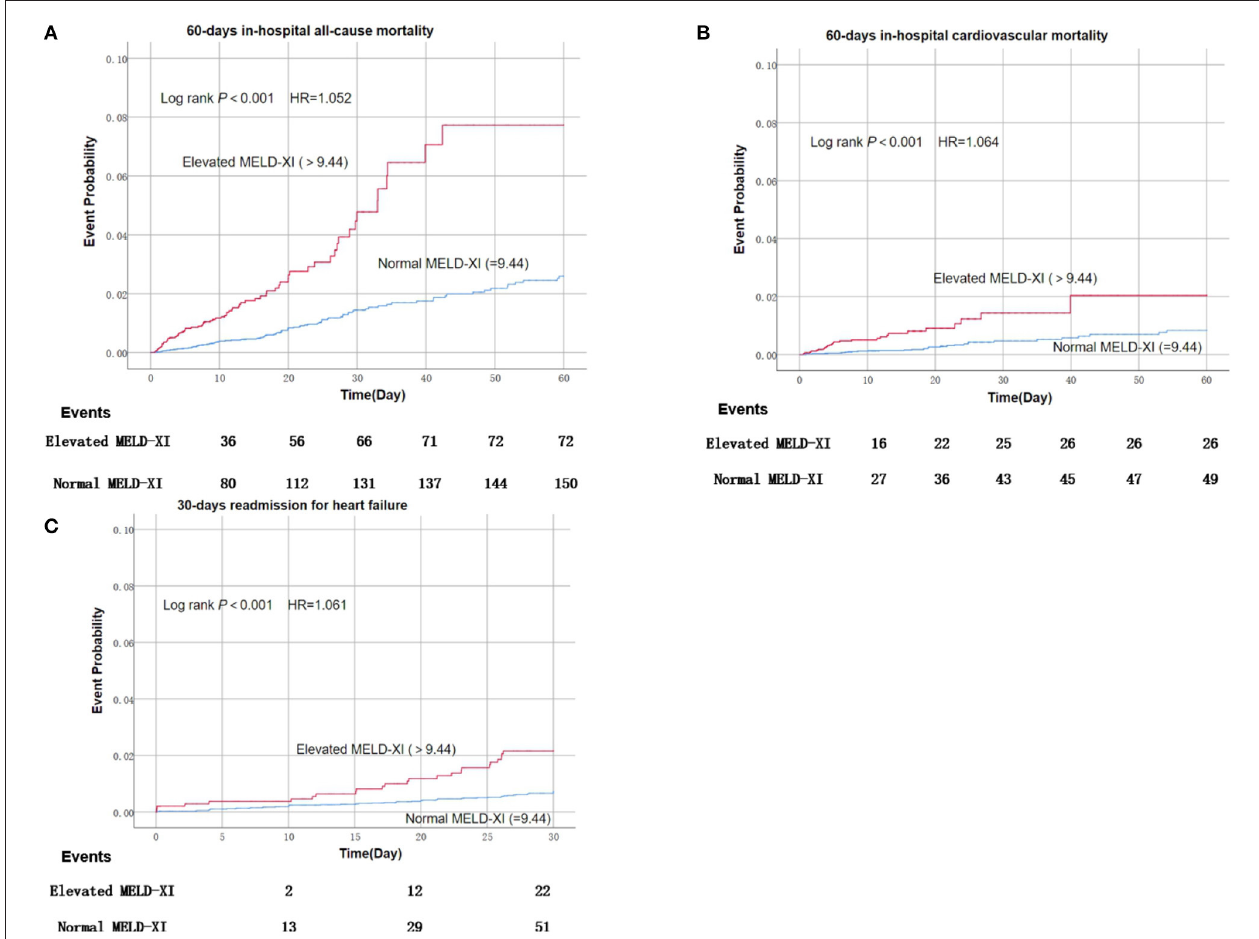
FIGURE 2 | (A-C) Area under the receiver operating characteristic curve of models predicting 60-day in-hospital all-cause mortality and cumulative events. Model 4: Adjusted for age, LVEF, NYHA class, WBC, triglyceride. Calculated as: − 0.015 + 0.019 × age − 14.604 × LVEF + 1.293 × NYHA class III (1) [OR 2.871 × NYHA Class IV (1)] + 0.046 × WBC(10 9 /L) + 0.118 × triglyceride(mmol/L). Model 4 + MELD-XI: − 0.420 + 0.024 × age − 14.488 × LVEF + 1.135 × NYHA class III (1) [OR 2.567 × NYHA Class IV (1)] + 0.043 × WBC(10 9 /L) + 0.109 × triglyceride(mmol/L) + 0.053 × MELD-XI. Model 4 + serum creatinine: − 0.163 + 0.021 ×